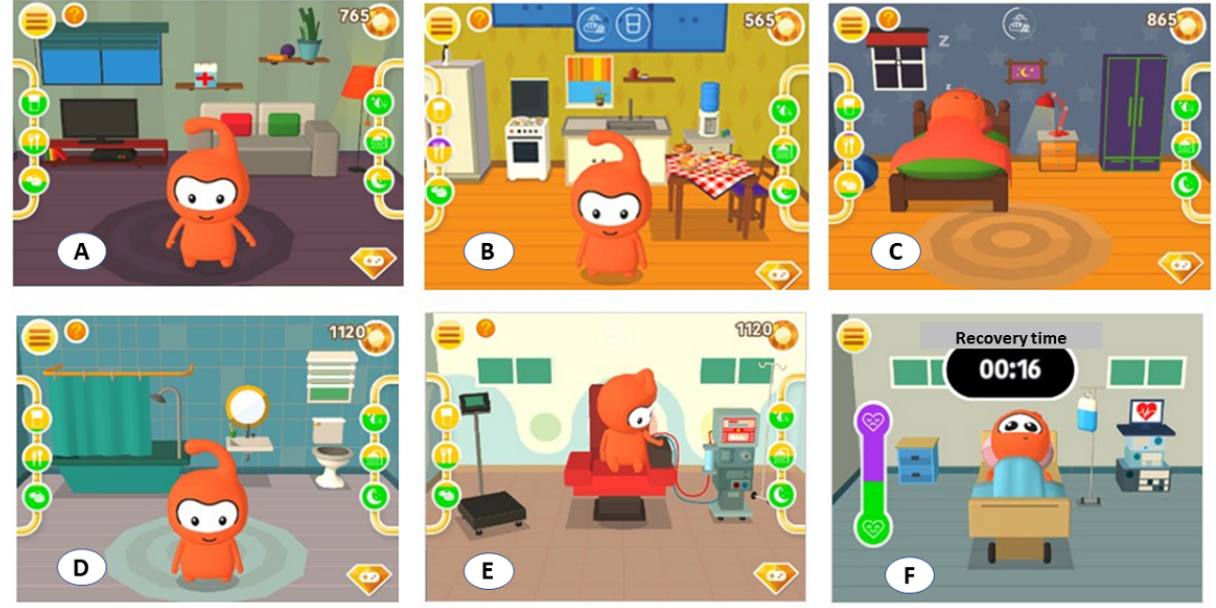
Figure 3. Scenarios in the serious game. A: living room; B: kitchen; C: bedroom; D: bathroom; E: hemodialysis room; F: hospital inpatient bed. At the sides, the scenarios display commands (icons and colors) that guide or indicate the proper care to guarantee a higher score.